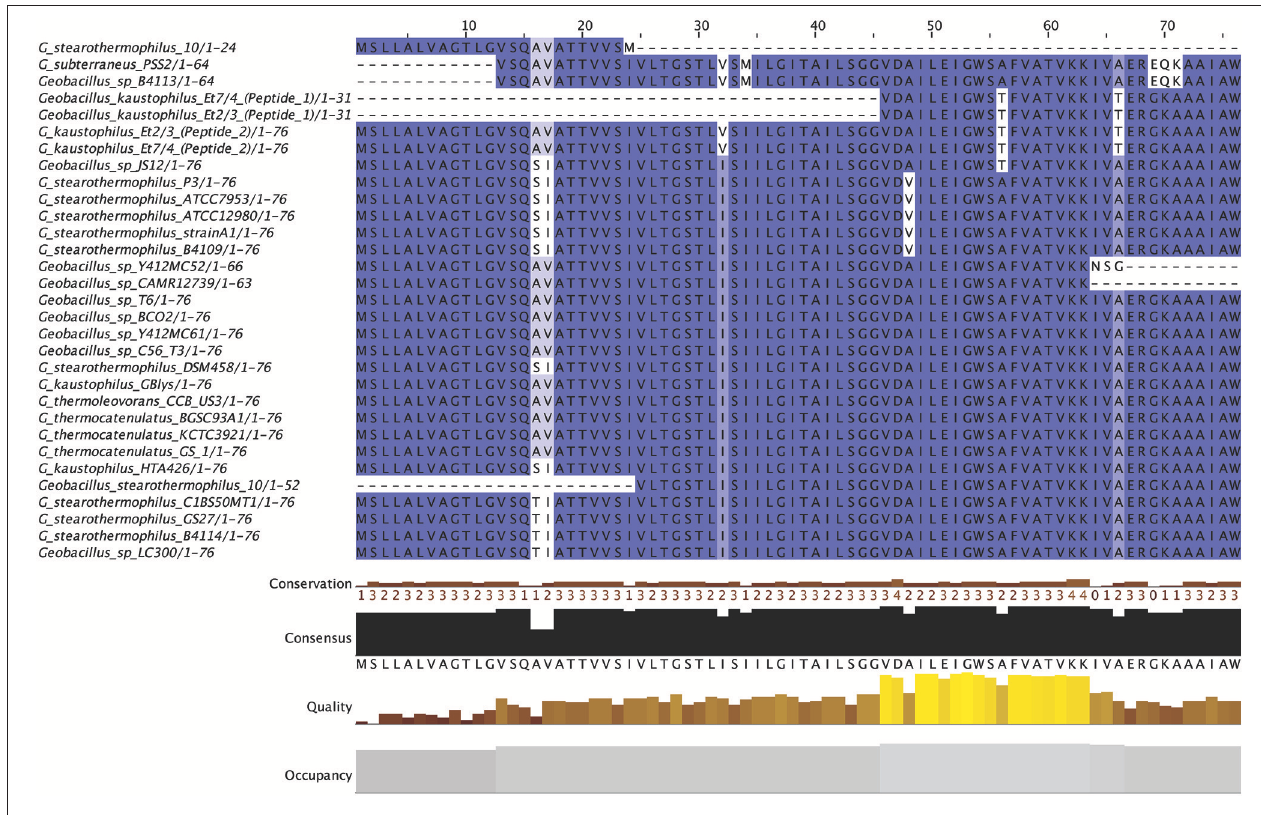
FIGURE 8 | MSA of circular peptides predicted by BAGEL3.